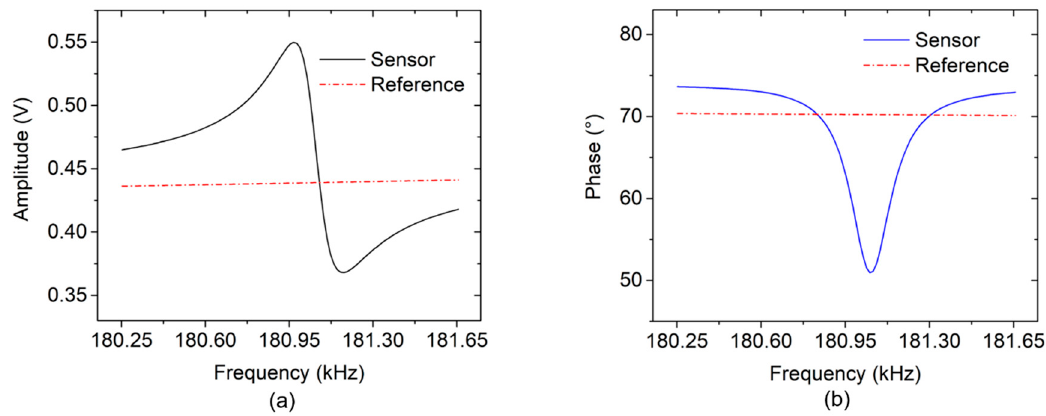
Figure 9. Measured sensor and reference signals: ( a ) amplitude with asymmetric shape and ( b ) phase with a reversed characteristic both with nearly constant references.